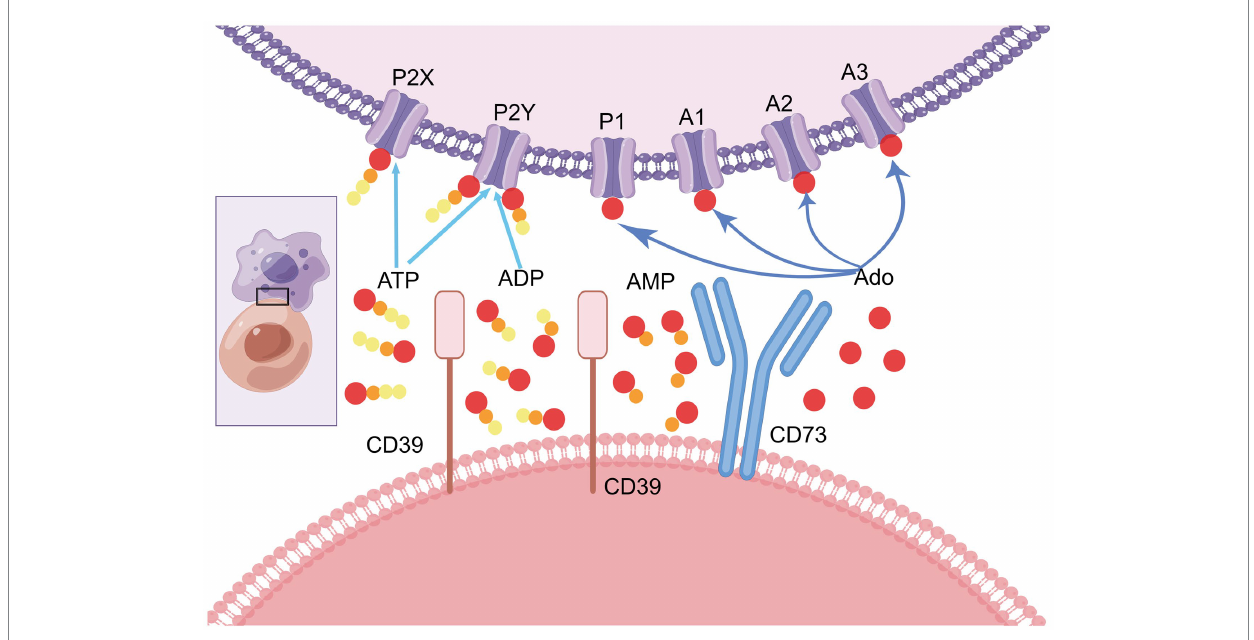
FIGURE 1 Adenosine signaling mediated by CD73. Affected by various environmental factors, extracellular pro-inflammatory risk factor ATP can bind to receptors such as P2X and P2Y to induce intense inflammation in the human body. Under the guidance of extracellular inflammation and energy balance mechanism, excessive pro-inflammatory ATP is gradually dephosphorylated to form AMP with the help of cell surface enzymes such as CD39, ALP and NTPases. AMP is further dephosphorylated by CD73 to produce adenosine which has immunosuppressive effects. Adenosine can tie to various adenosine receptors on cell surface like P1, A1, A2 and A3, and participate in various physiological and pathological reactions of the body, playing different functions and roles. CD73 is the absolute most significant hydrolytic protease for the conversion of AMP to adenosine. It is a critical step before adenosine binds to adenosine receptors and plays a vital role in the regulation and conduction of purine signaling pathways (by figdraw, export ID: